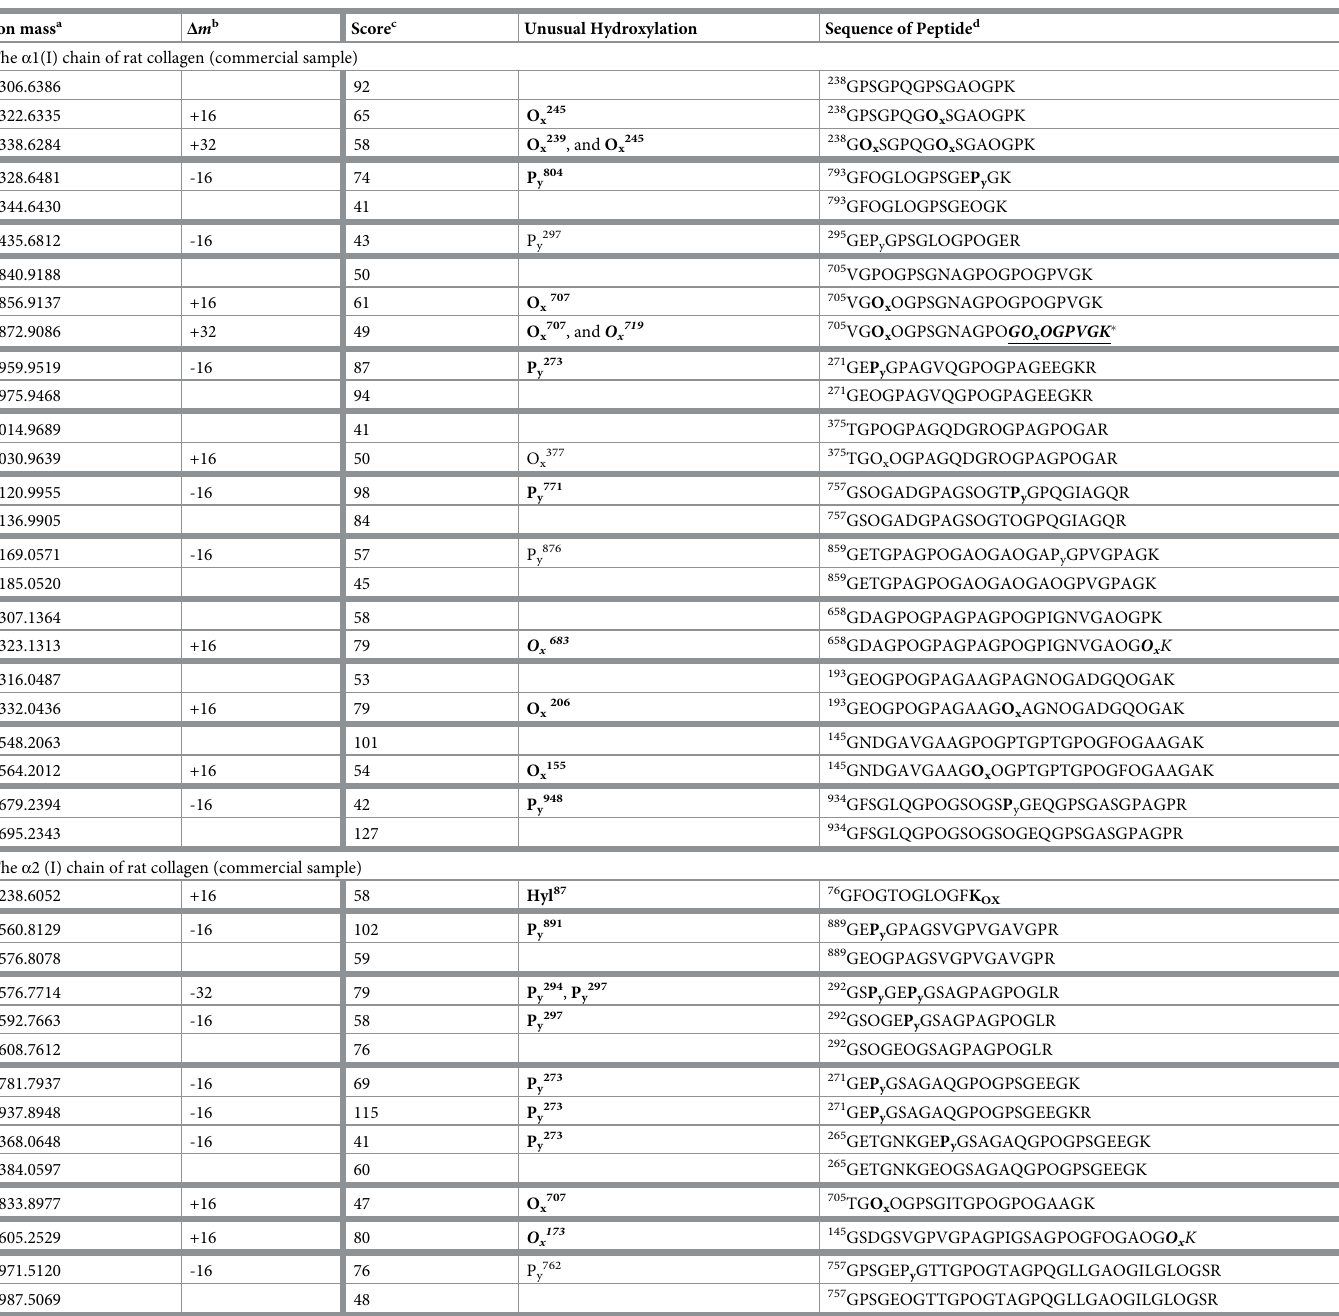
Table 1. Peptides of rat type I collagen with mass variants of 16 (the commercial